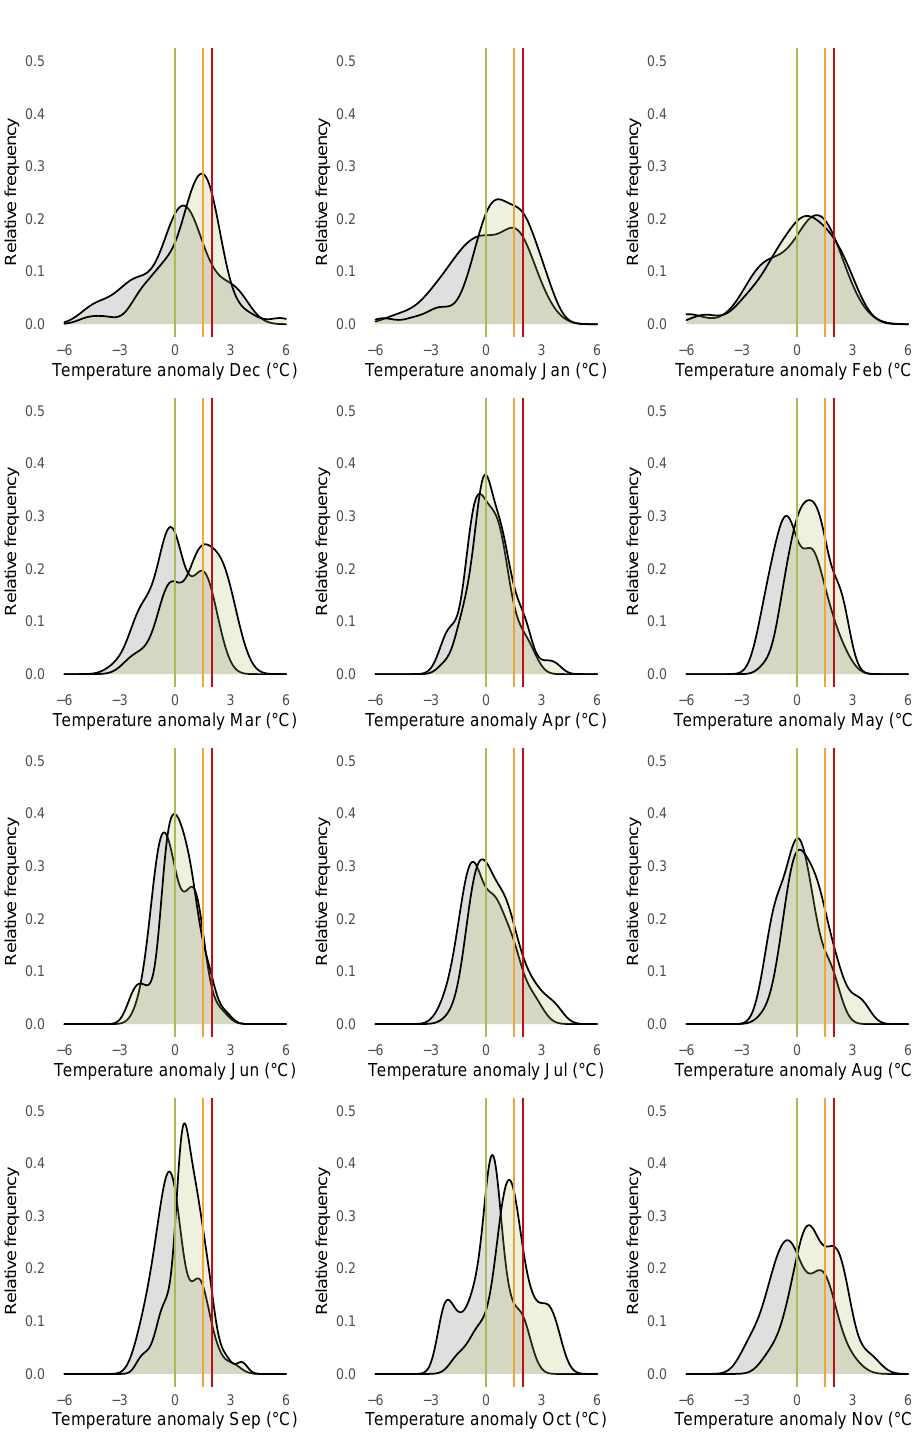
Figure 7. Empirical densities of anomalies plotted for each month from January 1850 until December 1900 (grey) and from January 1961 until December 2020 (green). Vertical lines indicate anomalies of 0 ◦ C (green), 1.5 ◦ C (orange), and 2 ◦ C